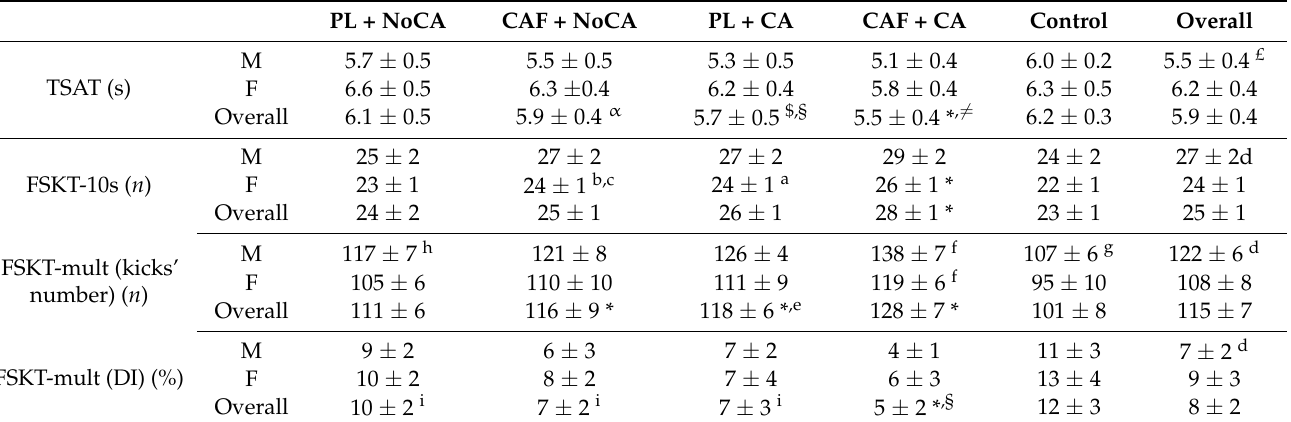
Table 1. Physical performances during taekwondo-specific tests following different conditions (values are mean ± SD; n =